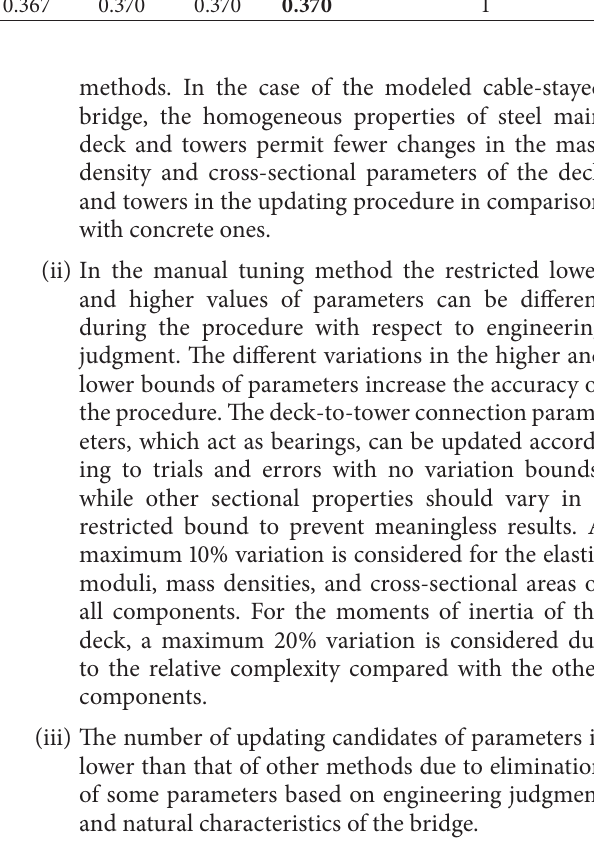
Figure 8: Sensitivity of modes to the parameters of towers and cables (TOW indicates tower